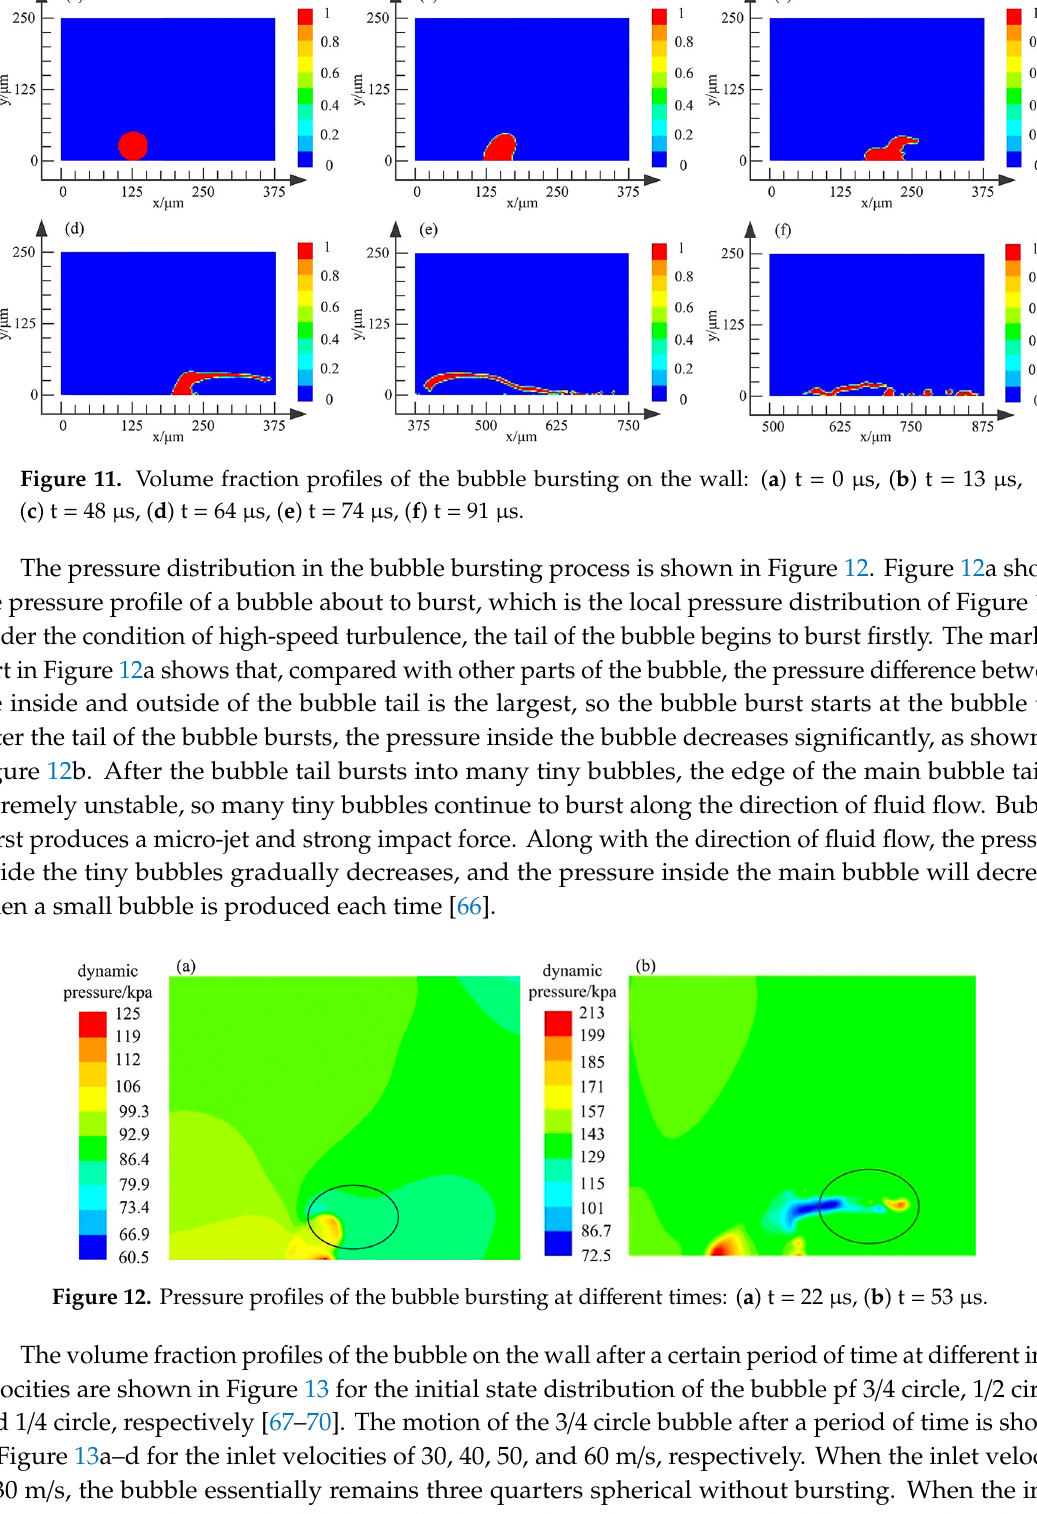
Figure 12. Pressure profiles of the bubble bursting at different times: (a) t = 22 μ s, (b) t = 53 μ s.